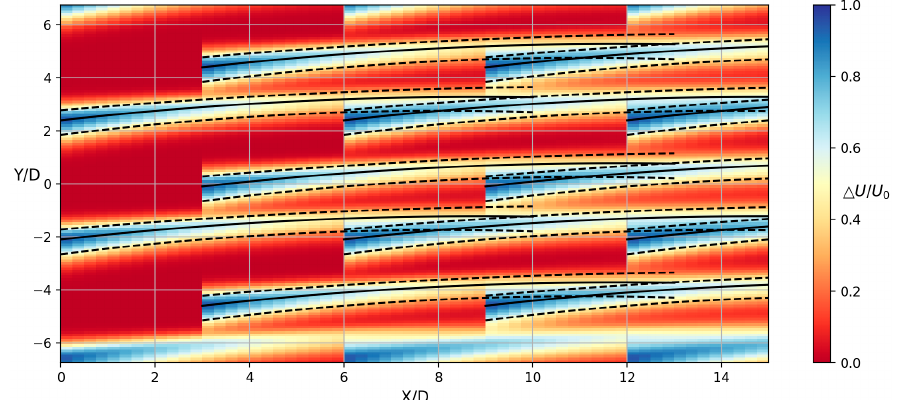
Figure 19. The velocity contour of the array, which is the optimal arrangement under the criterion of array power density